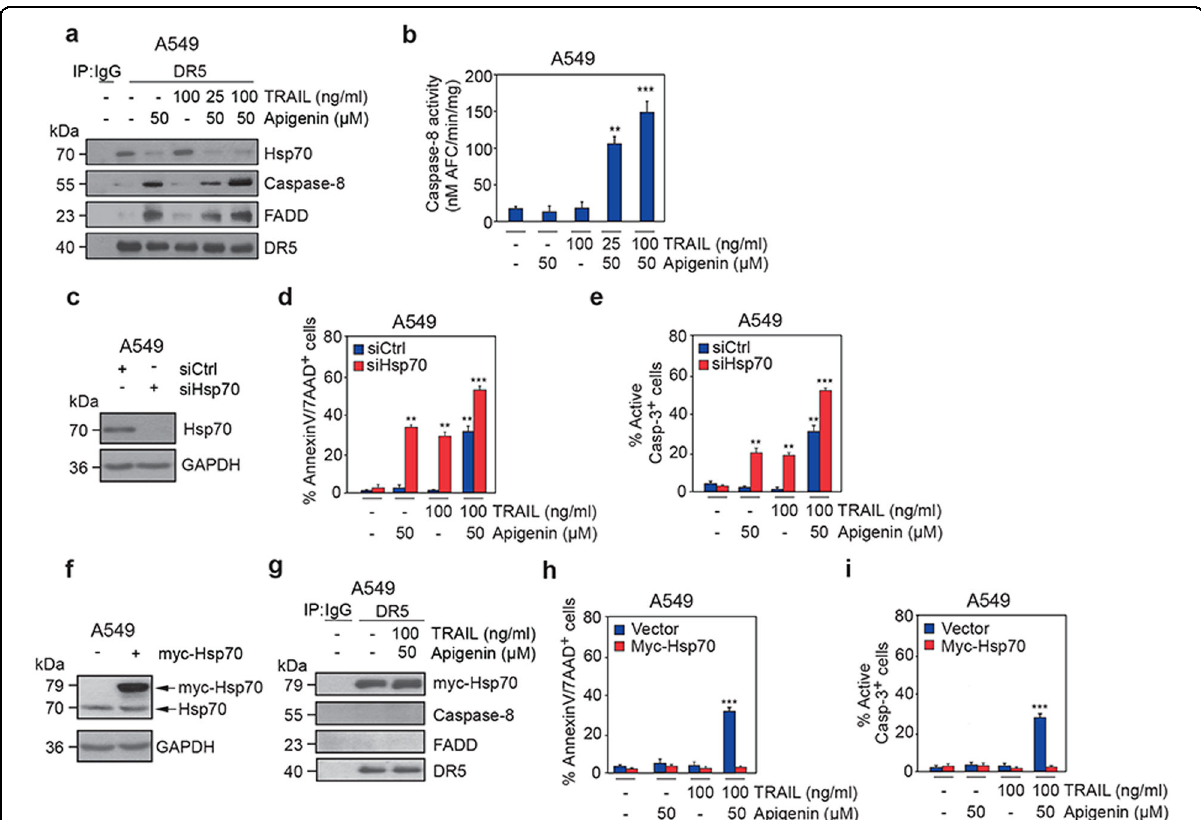
Fig. 5 Apigenin binding to Hsp70 increases the responsiveness of lung cancer cells to TRAIL treatment by promoting DISC recruitment to the DR5 receptor. a DR5 association with components of the DISC was evaluated by immunoprecipitation using anti-DR5 antibodies (IP: DR5) or an IgG isotype control (IP: IgG) in lysates from A549 cells pretreated with 50 μ M apigenin for 18 h followed by 25 or 100 ng/ml TRAIL or DMSO (-) for 6 h or treated with 100 ng/ml TRAIL or DMSO (-) and then immunoblotted with anti-Hsp70, anti-caspase-8, anti-FADD and anti-DR5 antibodies. b Caspase-8 activity was determined by IETD-AFC activity assays in the same lysates used in ( a ) and measured as moles of free AFC released per minute reaction time by each mg of protein. c Western blot analysis from A549 cells transiently transfected with Hsp70 siRNA (siHsp70) or scramble siRNA control (siCtrl) and immunoblotted with anti-Hsp70 antibodies. The same membrane was reblotted with anti-GAPDH antibodies to measure GAPDH as a loading control. d The percentage of apoptotic cells was assessed by fl ow cytometric analysis of Annexin V/7-AAD in A549 cells that were transiently transfected with siHsp70 or siCtrl and then pretreated with 50 μ M apigenin or DMSO (-) for 18 h followed by 100 ng/ml TRAIL or DMSO (-) for 6 h. e The percentage of cells with active caspase-3 was evaluated in the cells ( d ) by immunostaining with an antibody that recognized active anti-caspase-3 and determining cell counts by fl ow cytometry. The data are expressed as the mean ± SEM ( n = 3; ** P < 0.01, and *** P < 0.001; and analyses were performed by one-way ANOVA). f Western blot analysis of A549 cells transiently transfected with myc-Hsp70 ( + ) or pCDNA3-myc vector control (-) and immunoblotted with an anti-Hsp70 antibody, which indicates the levels of overexpressed myc-tagged Hsp70 or endogenous Hsp70. The same membrane was reblotted with an anti-GAPDH antibody to measure GAPDH, which served as a loading control. g DR5 association with components of the DISC was evaluated by immunoprecipitation as described in ( a ) using lysates from myc-Hsp70-overexpressing A549 pretreated with 50 μ M for 18 h and then with 100 ng/ml TRAIL for 6 h or DMSO (-). Immunoblotting was performed as described in ( a ). h The percentage of apoptotic cells was assessed by fl ow cytometry using AnnexinV/7-AAD in A549 cells transiently transfected with myc-Hsp70 or pCDNA3-myc vector control and pretreated with 50 μ M apigenin or DMSO (-) for 18 h and then followed by 100 ng/ml TRAIL or DMSO (-) for 6 h. i The percentage of cells with active caspase-3 was evaluated by immunostaining with an antibody that recognizes active caspase-3 and determining cell counts by fl ow cytometry analysis of eth same cells used in ( h ). All data are presented as the mean ± SEM of three independent experiments (** P < 0.01, and *** P < 0.001; and analyses were performed by one-way